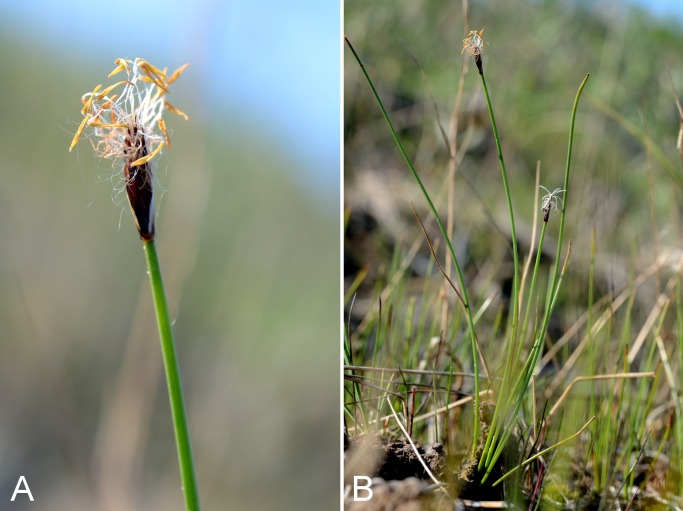
Eleocharis quinqueflora.(A) Inflorescence, Saarela et al. 3971. (B) Habit, Saarela et al. 3971. Photographs by R. D. Bull.